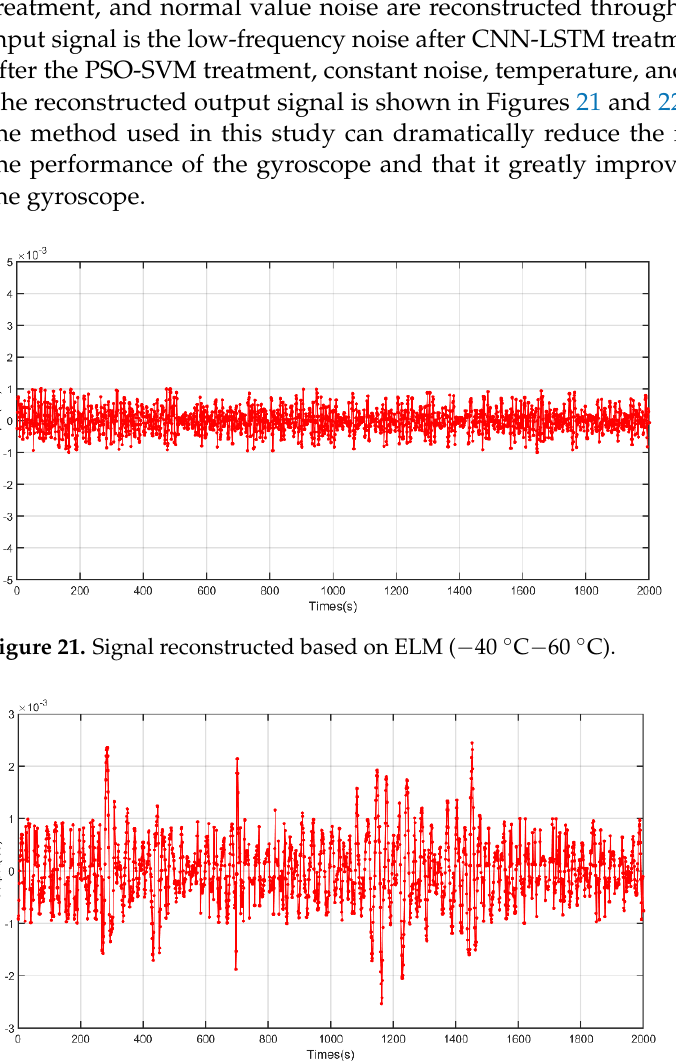
Figure 22. Signal reconstructed based on ELM (60 °C –− 40 °C).